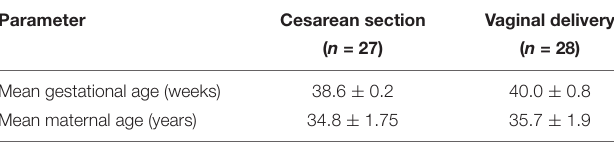
TABLE 1 | Clinical characteristics of the